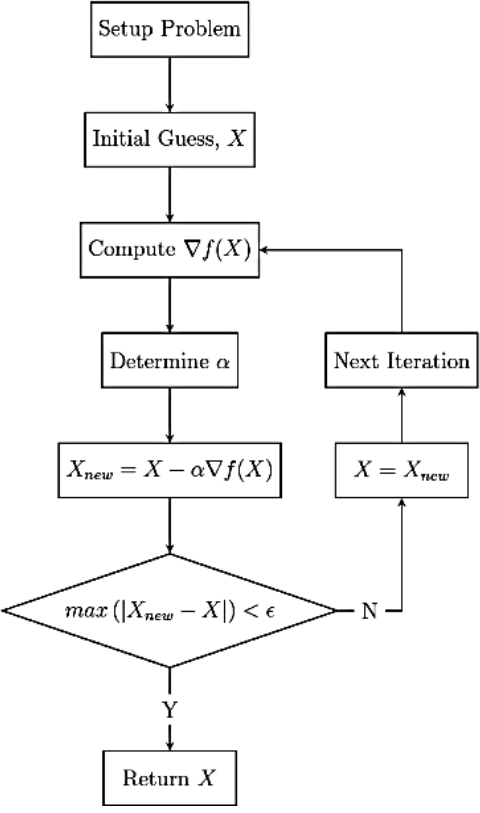
Figure 24. Flow chart of method of steepest descent.